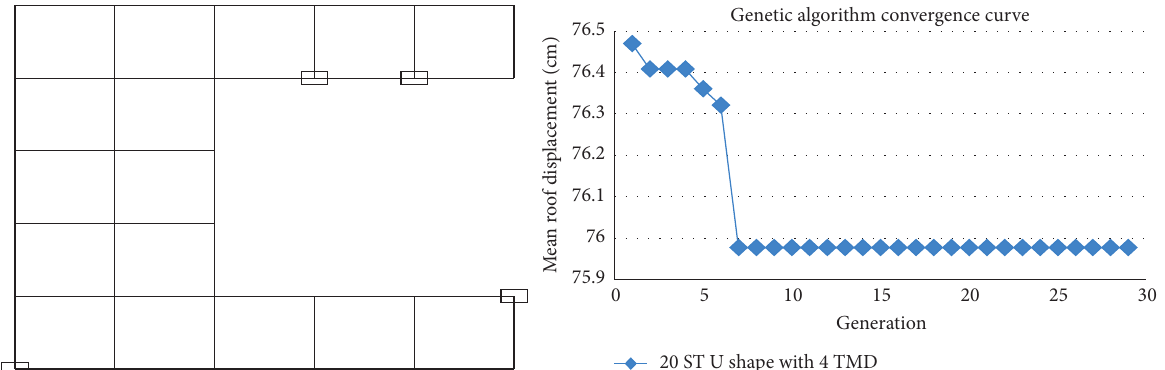
Figure 32: Convergence diagram of the twenty-story irregular U-shaped model with 4 dampers in genetic algorithm (right) and damper optimal positions (left).